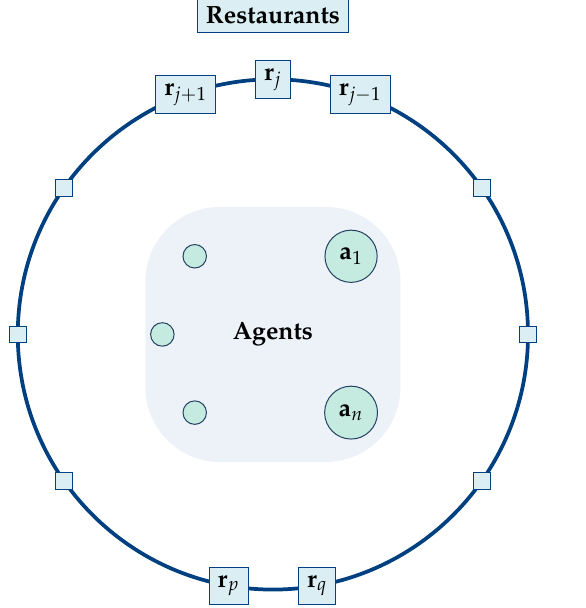
Figure 2. In the original formulation of the KPRP, the above spatial layout is strictly